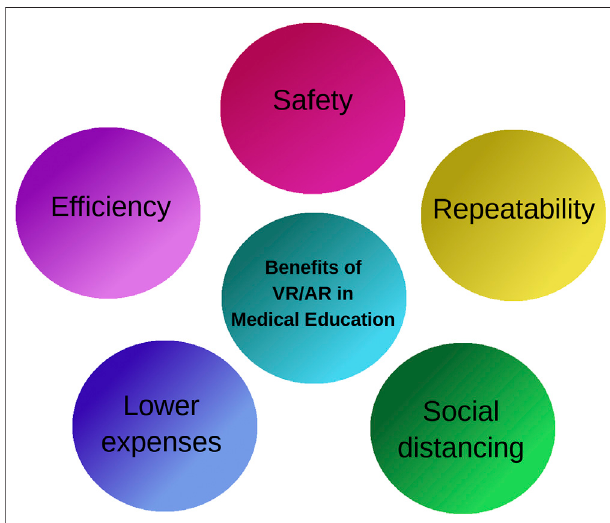
FIGURE 2 | VR/AR advantages in medical